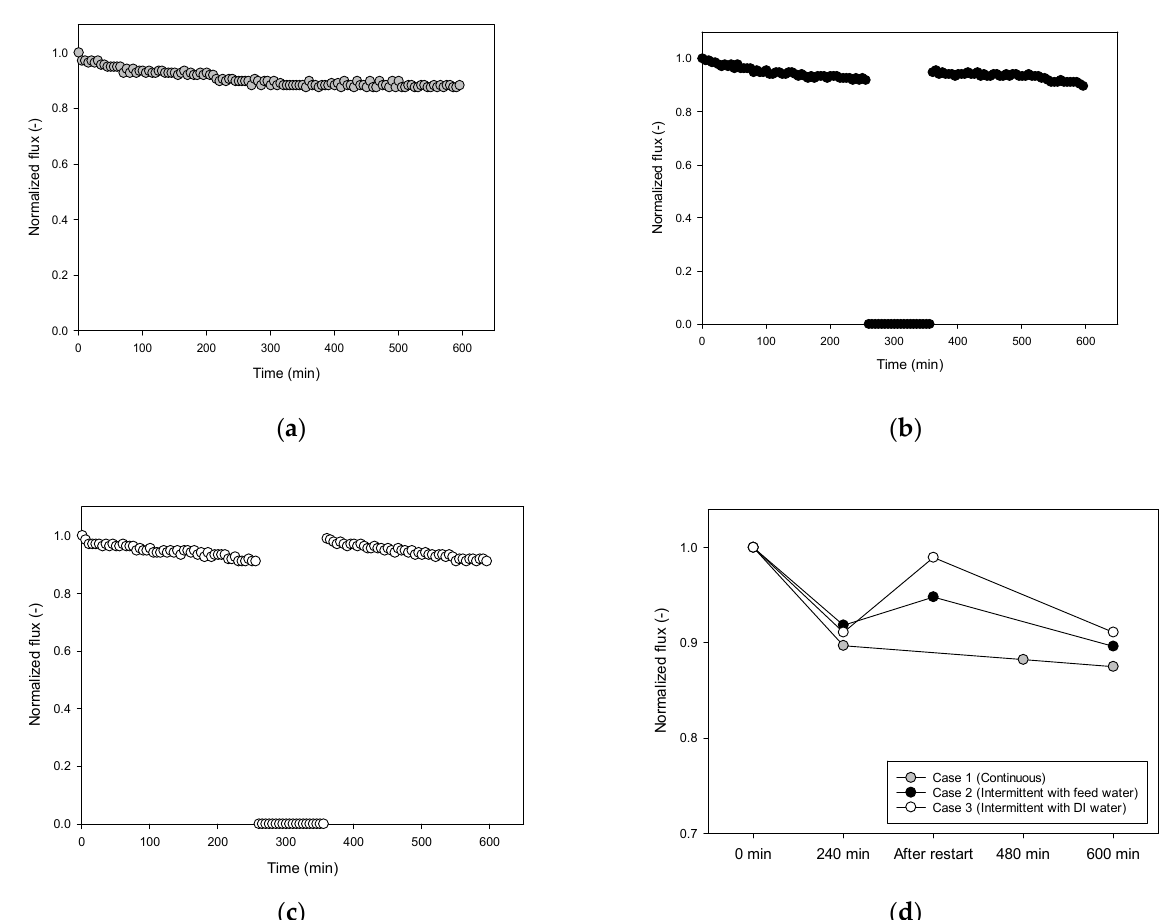
Figure 3. Time ‐ dependent fl ux pro fi les for 600 min of RO operation. ( a ) Continuous operation (Case 1), ( b ) intermi tt ent operation with feed water storage (Case 2), ( c ) intermi tt ent operation with DI 1), ( b ) intermittent operation with feed water storage (Case 2), ( c ) intermittent operation with DI water storage (Case 3), and ( d ) comparison of fl ux variations. water storage (Case 3), and ( d ) comparison of flux